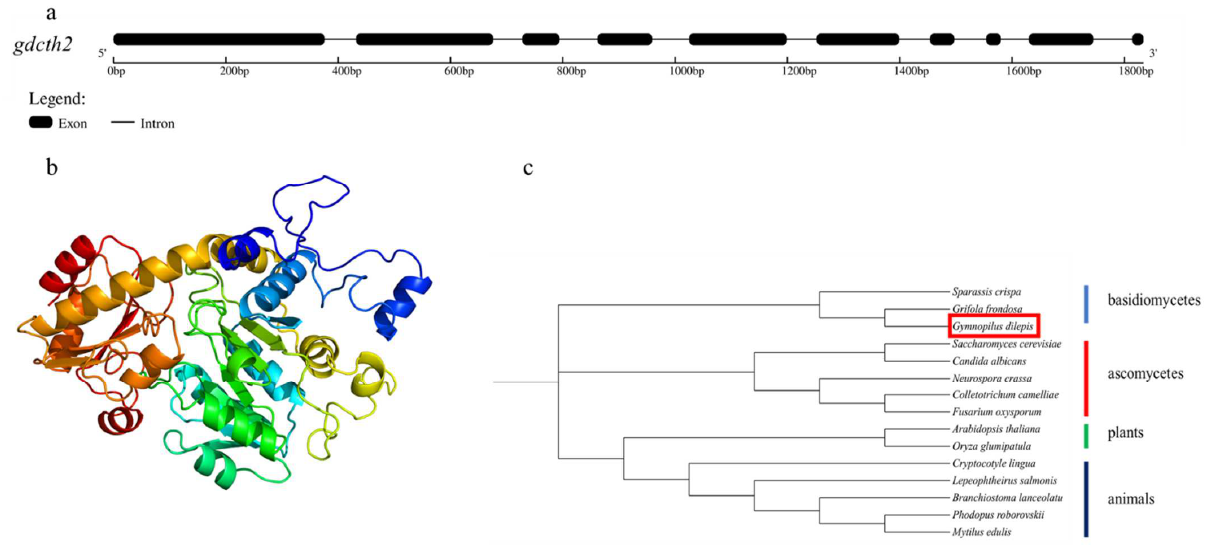
Figure 9. The characteristic of gdcth2 . (( a ): gene structure of gdcth2 ; ( b ): protein structure of CTH; ( c ): phylogenetic tree analysis of several CTH amino acid sequences).